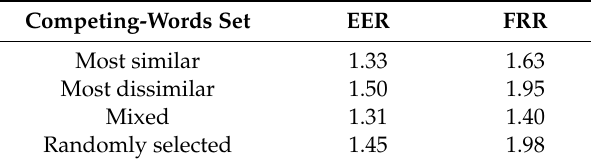
Table 4. Performance comparison of the proposed system for di ff erent sets of the competing words